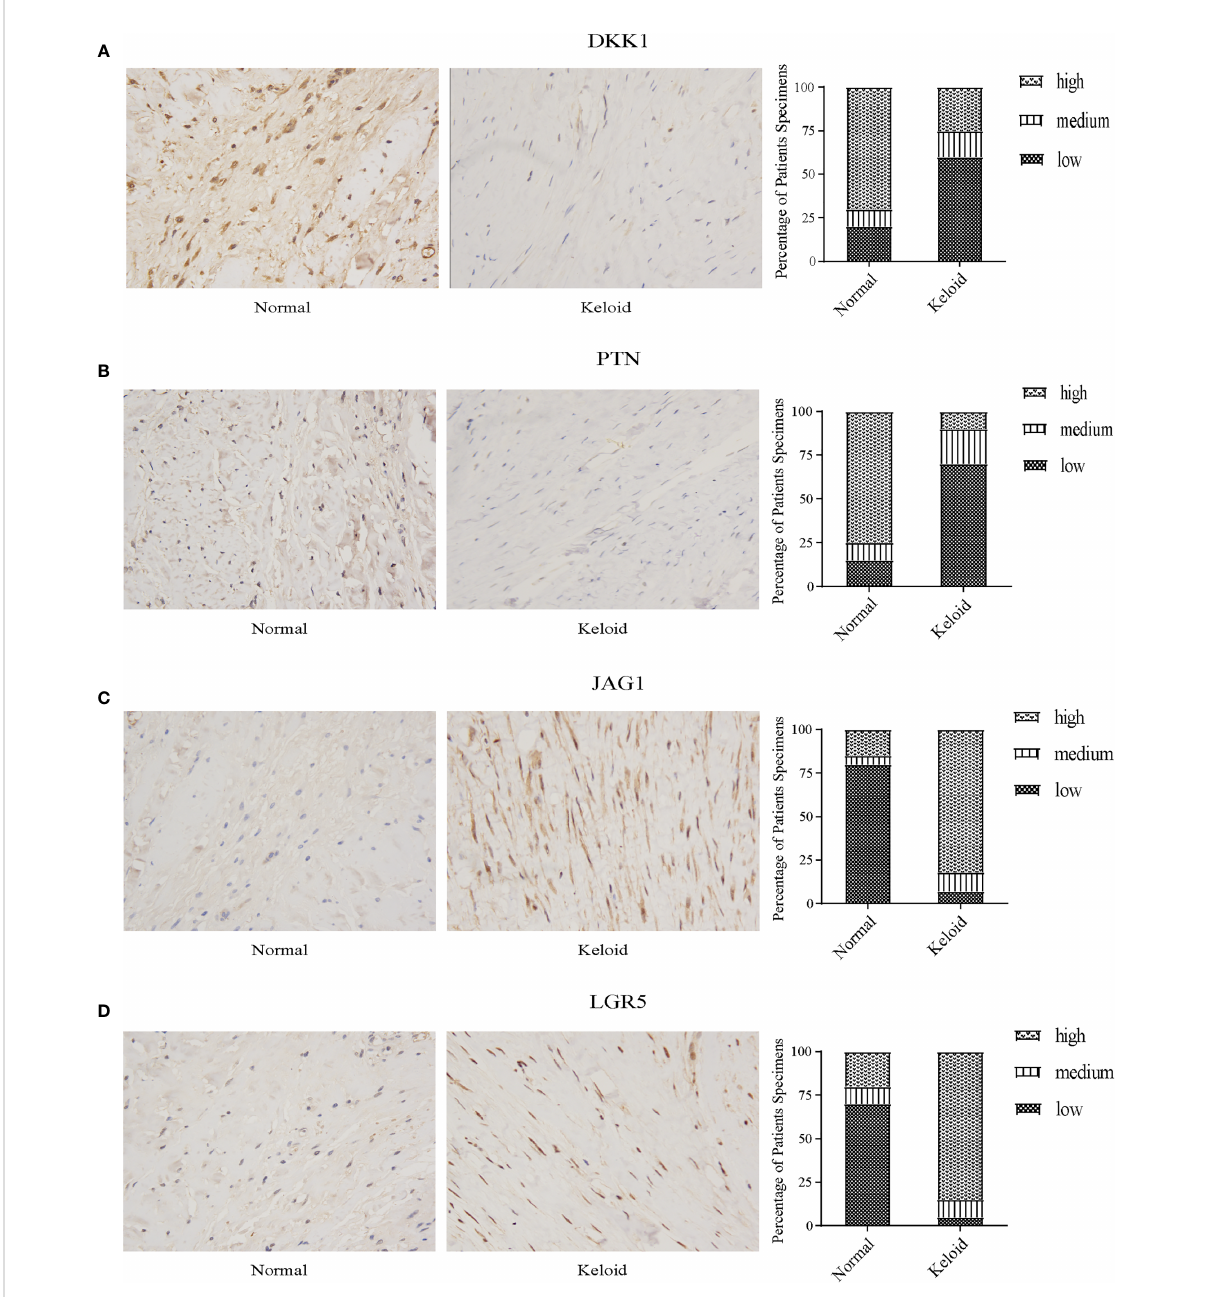
FIGURE 11 Immunohistochemistry staining and histologic scoring. (A) Expression of DKK1 in normal tissue and keloid. (B) Expression of PTN in normal tissue and keloid. (C) Expression of JAG1 in normal tissue and keloid. (D) Expression of LGR5 in normal tissue and